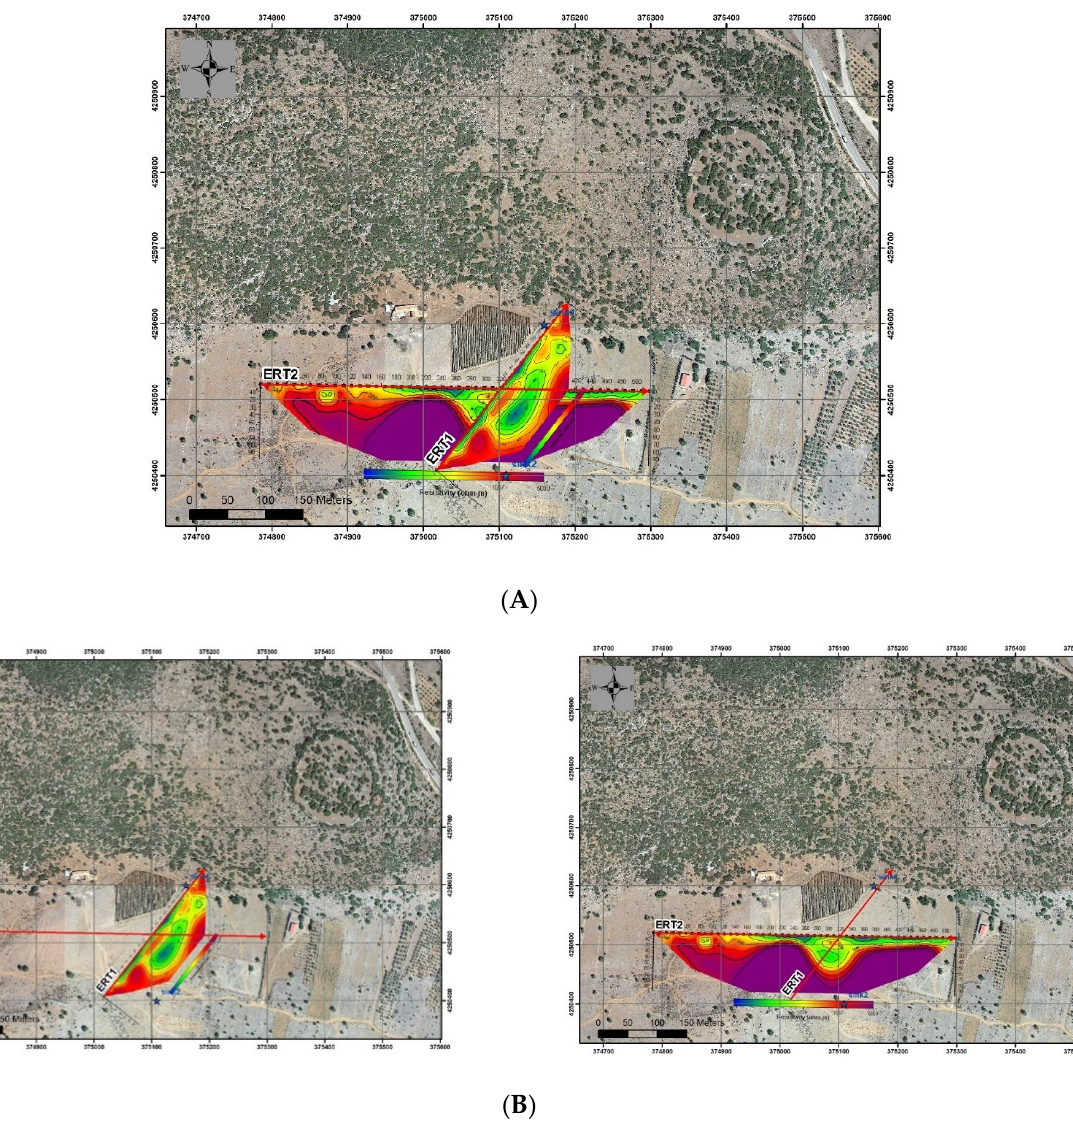
Figure 7. ( A ) Fence diagram of the electrical topographies (ERT1 and ERT2) and ( B ) the ERTs of the Meteles basin shown such that their relation to the basin becomes apparent. Axis numbers are the HGS (Hellenic Geodetic System) 1987 coordinates in meters.